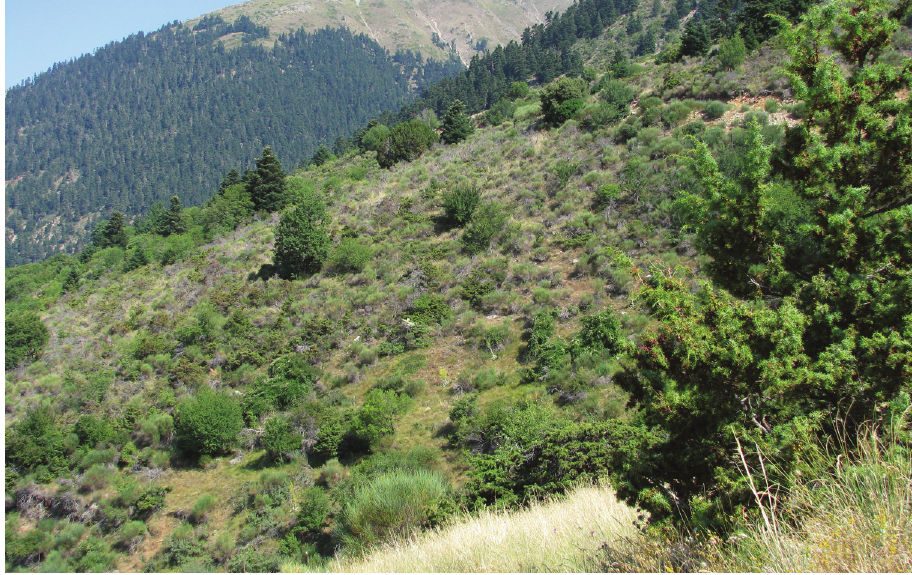
Figure 32. Habitat of P. timfristos . Central Greece, Mt. Timfristos, near Karpenisi, 1200 m, 20 July 2008. Photo by V.A.